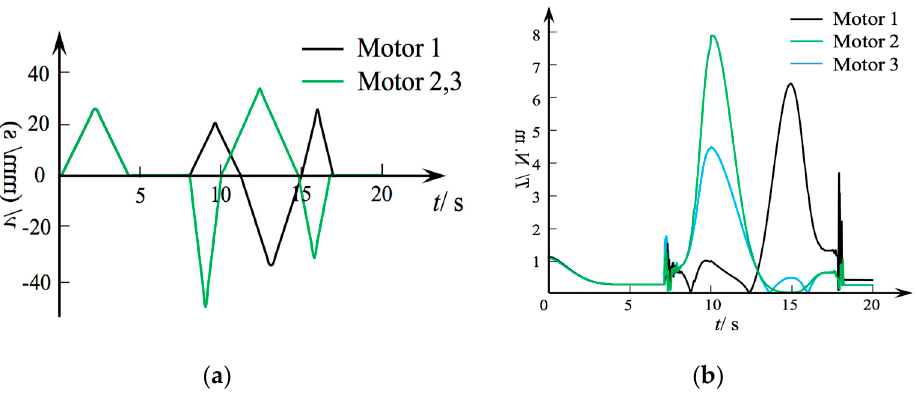
Figure 9. Input speed and torque of three motors. ( a ) Input speed vs. time curve. ( b ) Input torque vs. time curve.